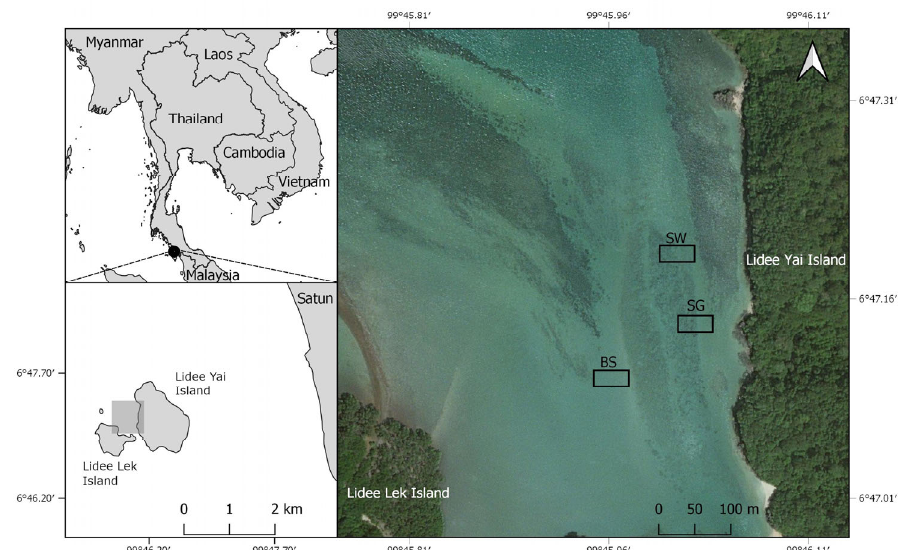
Figure 1. Study site at Lidee Islands, Mu Ko Phetra National Park, in the Andaman Sea, Satun Province. SW: seaweed habitat; SG: seagrass habitat; BS: bare sand habitat. The study site was surveyed and divided into three habitat types: a seaweed habitat with dominant H. macroloba , a agrass habitat with dominant H. ovalis , (cid:3) and a bare sand habitat. The estimated area of each habitat was around 1 km 2 .